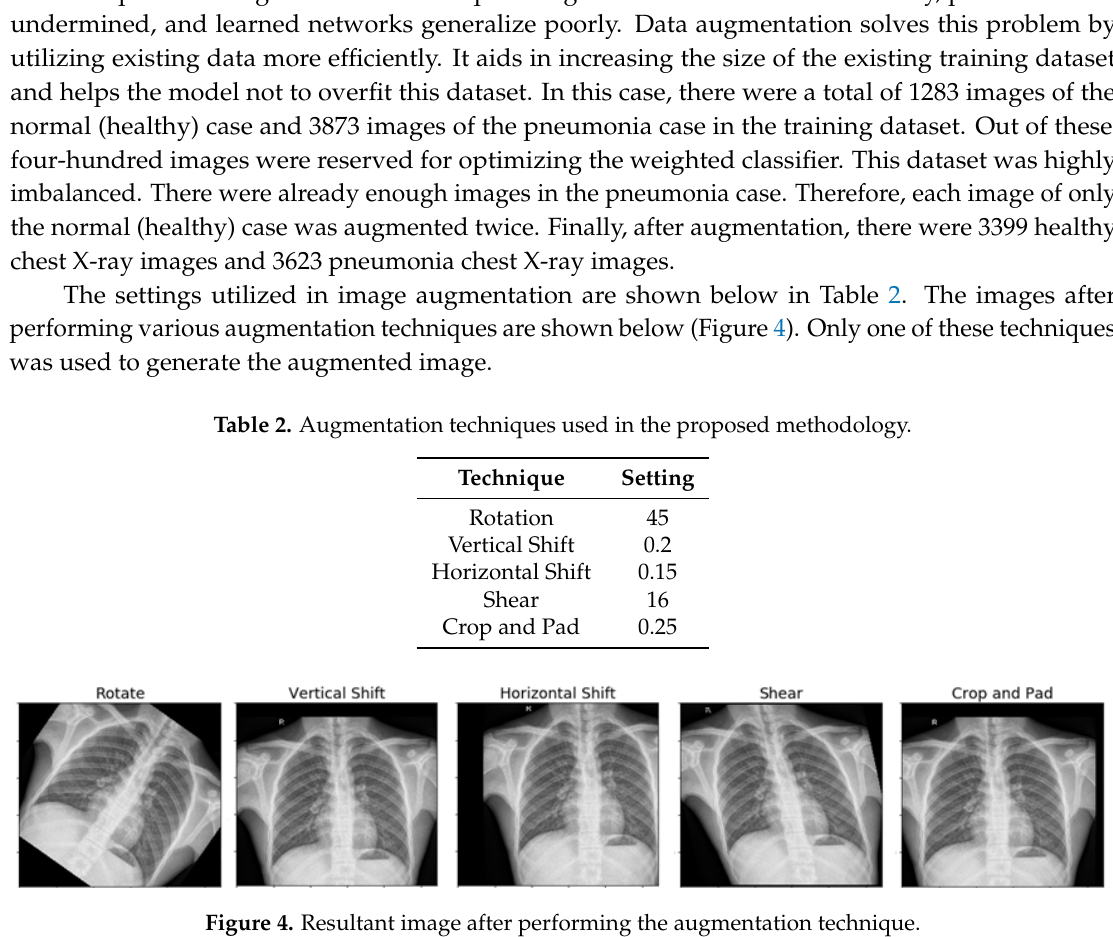
Figure 4. Resultant image after performing the augmentation